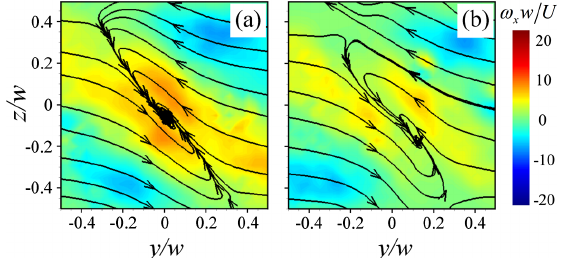
FIG. 6. Experimental dimensionless vorticity fields in the x ¼ 0 plane at ε ¼ 0 . 15 for (a) c ¼ 0 . 01 wt % PEO in water (El ¼ 0 . 011 , Re ¼ 19 . 7 ) and (b) c ¼ 0 . 03 wt % PEO in water (El ¼ 0 . 078 , Re ¼ 17 . 2 ). Under these conditions the flow exhibited mild unsteadiness and the images shown are averaged over 15 individual fields. The color scale indicates the dimen- w=U ). Superimposed streamlines exhibit the sionless vorticity ( ω x directionality of the flow. See also the videos contained in the Supplemental Material [78]. FIG. 7. Order parameter ψ as a function of Re for solutions of PEO in water, with the viscosity ratio spanning 0 . 24 < β < 1 for the experimental fluids. Closed symbols indicate data obtained with increasing flow rates and open symbols indicate data obtained with decreasing flow rates. Data are fitted with the Landau model [Eq. (8), solid lines]. Numerical data are obtained with the FENE-MCR model with L 2 ¼ 5000 and constant